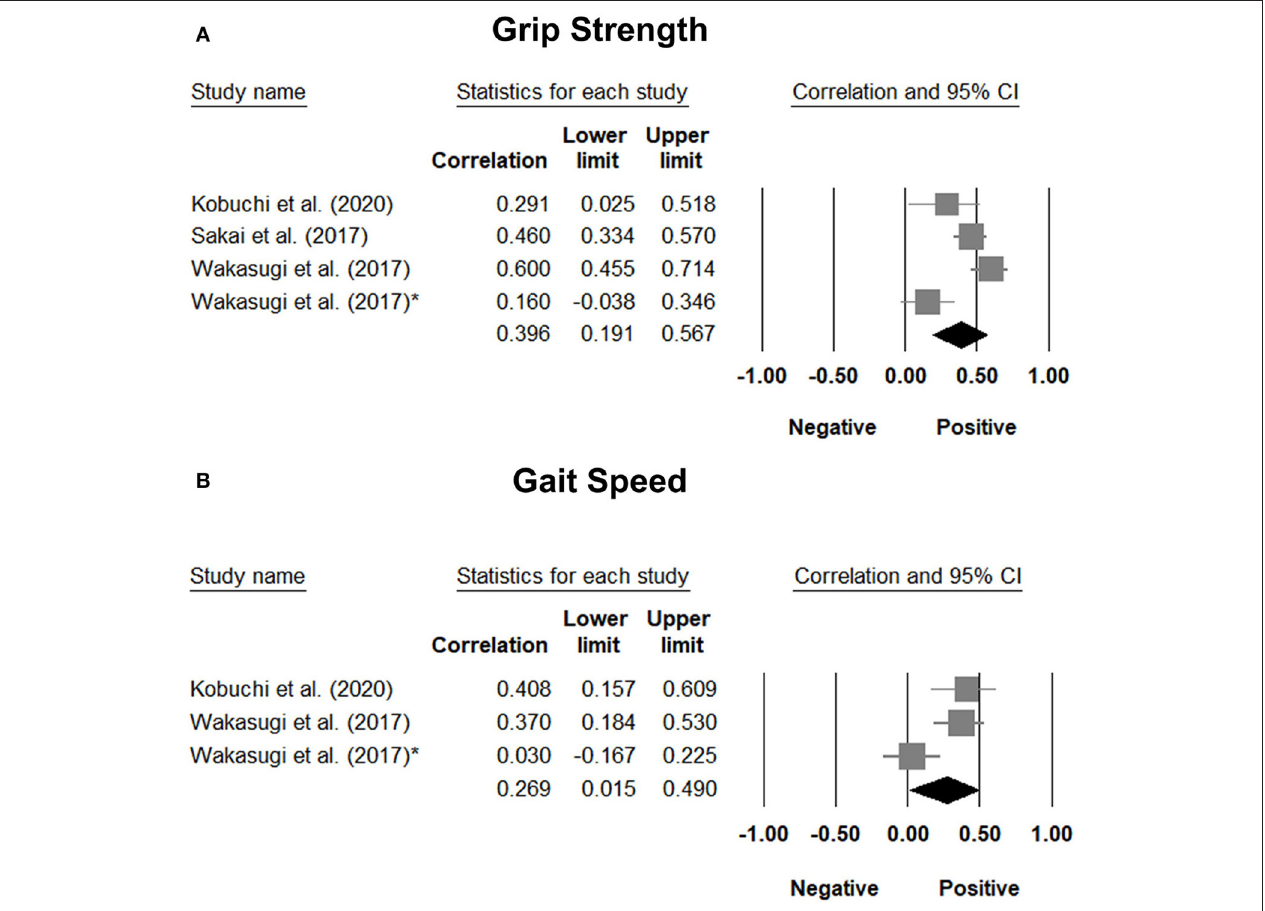
FIGURE 8 | Forest plot of the correlation analysis between tongue pressure and grip strength (A) and between tongue pressure and gait speed (B) . In the study performed by Wakasugi et al., the correlation analysis was conducted based on different genders. The one without the asterisk is the male subgroup, where as the one with the asterisk is the female